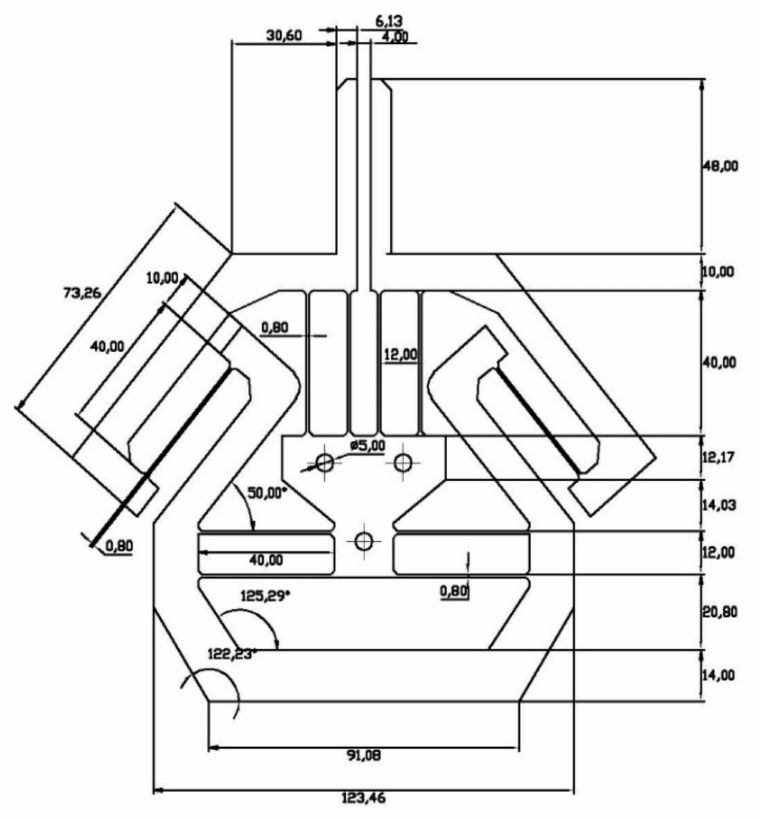
Figure 6. Geometry parameters of the case study (unit in